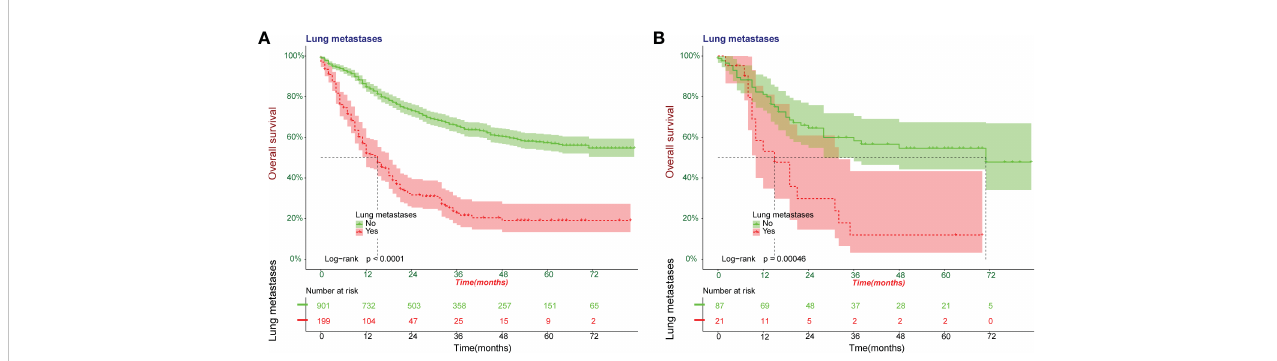
FIGURE 3 Kaplan-Meier survival curves were plotted for overall survival for patients with Osteosarcoma. A cohort of all patients was included to construct Kaplan- Meier survival curves (A) . Kaplan-Meier survival curves in external validation cohort (B)